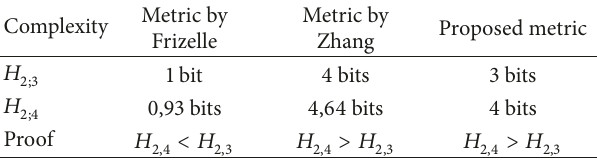
Table 7: Static complexity values and their proof.